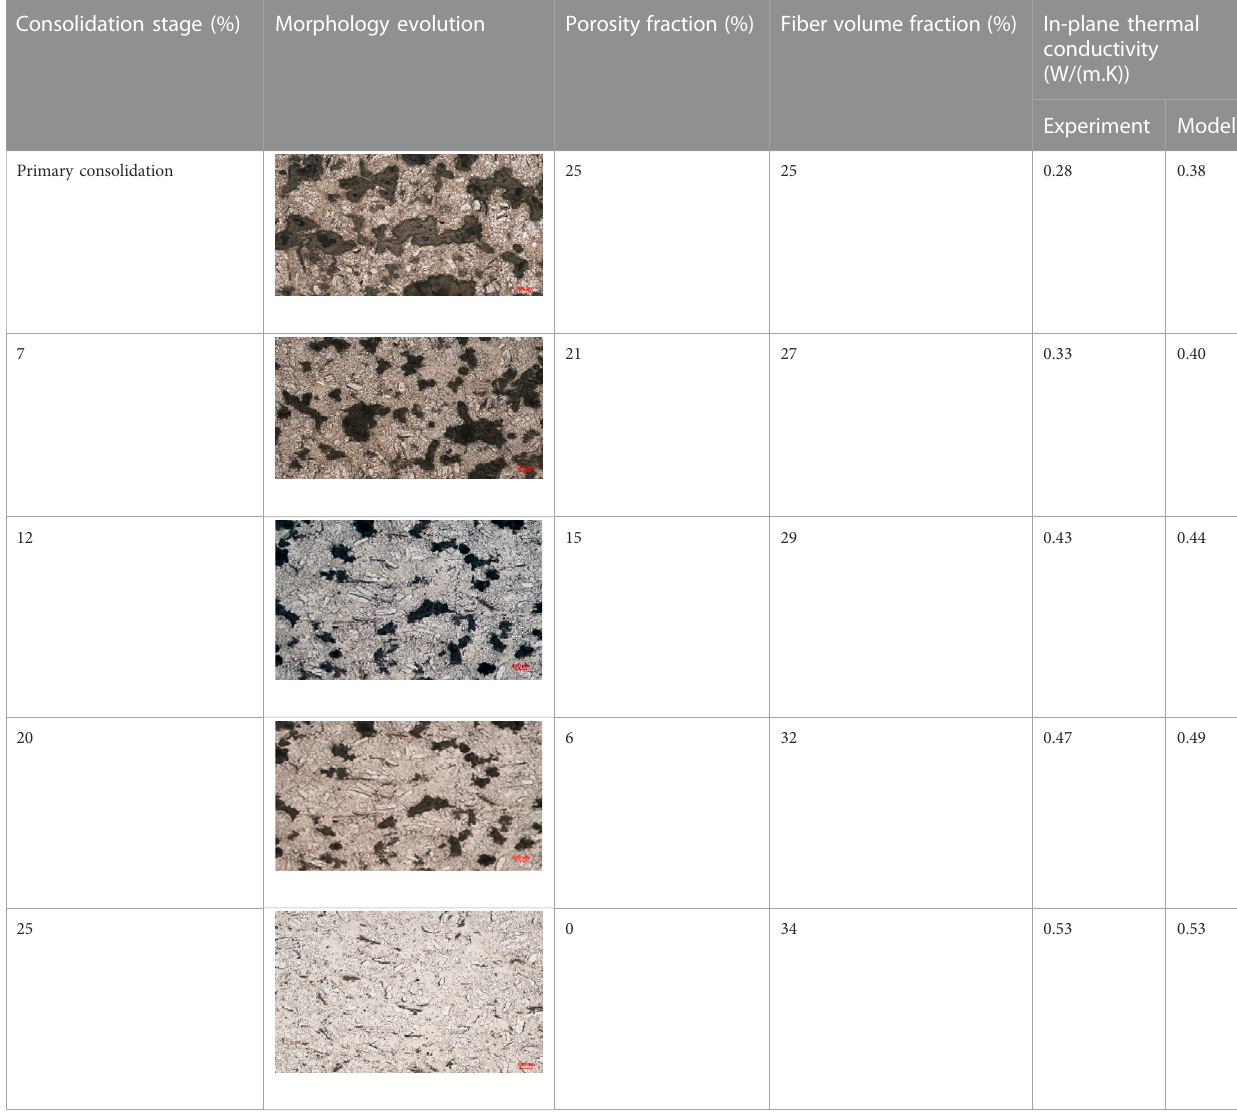
TABLE6Morphologyevolution andthermalconductivityatdifferenttheconsolidationstagesof fl ax/PP.Asthereisnochangeintransversethermalconductivity, the results are not presented. Consolidation stage